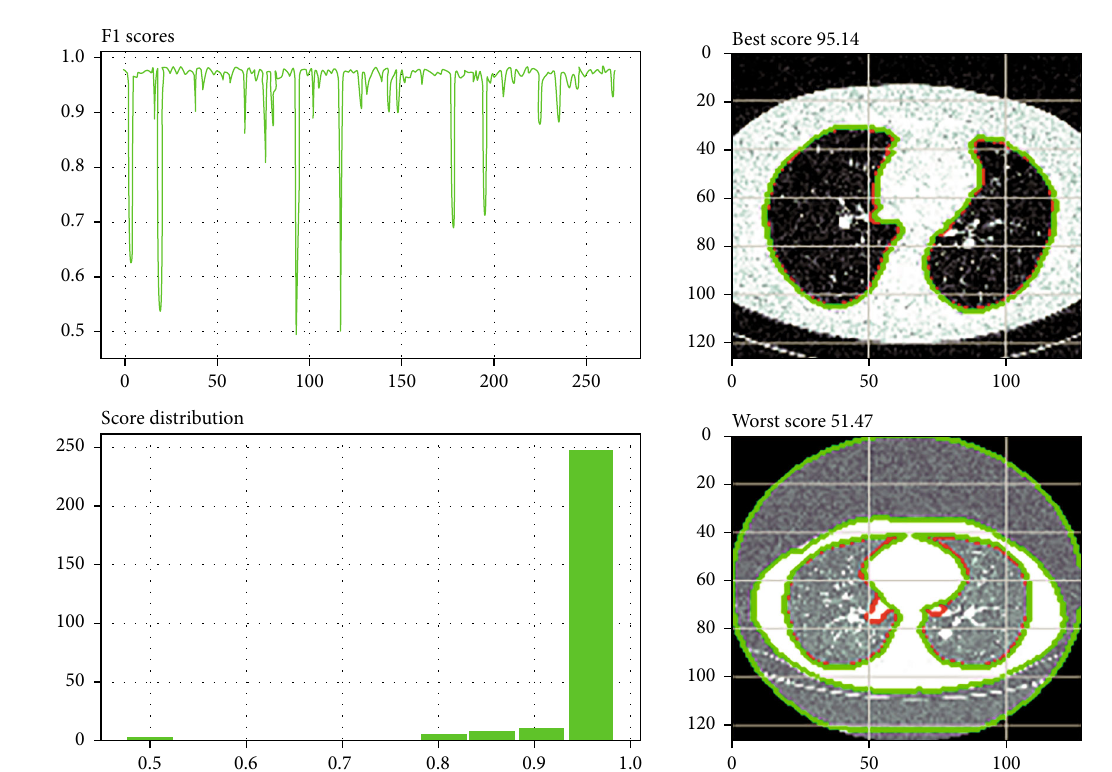
Figure 8: SegChaNet ’ s best and worst performance